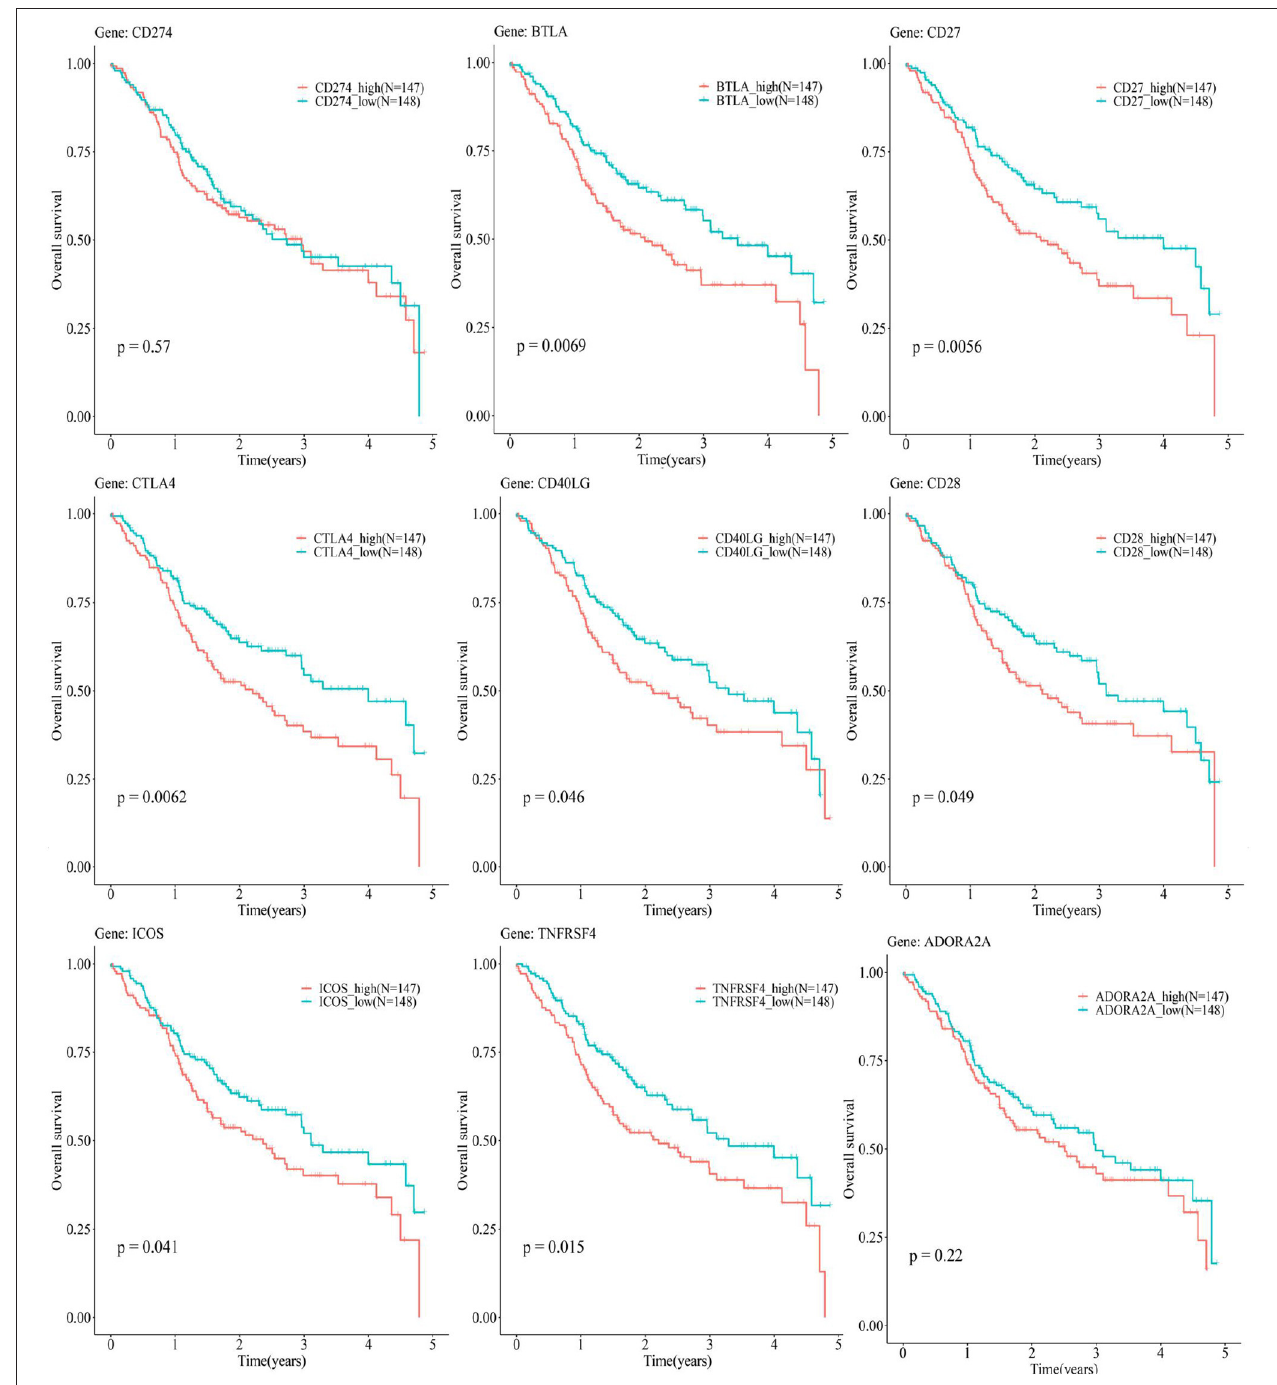
FIGURE 8 | The Kaplan–Meier (KM) plots show the relationship between the 5-year OS and CD274-related ICGs [CD274 and its eight positively correlated ICGs (BTLA, CD27, CTLA4, CD40LG, CD28, ICOS, TNFRSF4, and ADORA2A)]. The red curves indicate the low-expression group, whereas the blue curves indicate the high-expression